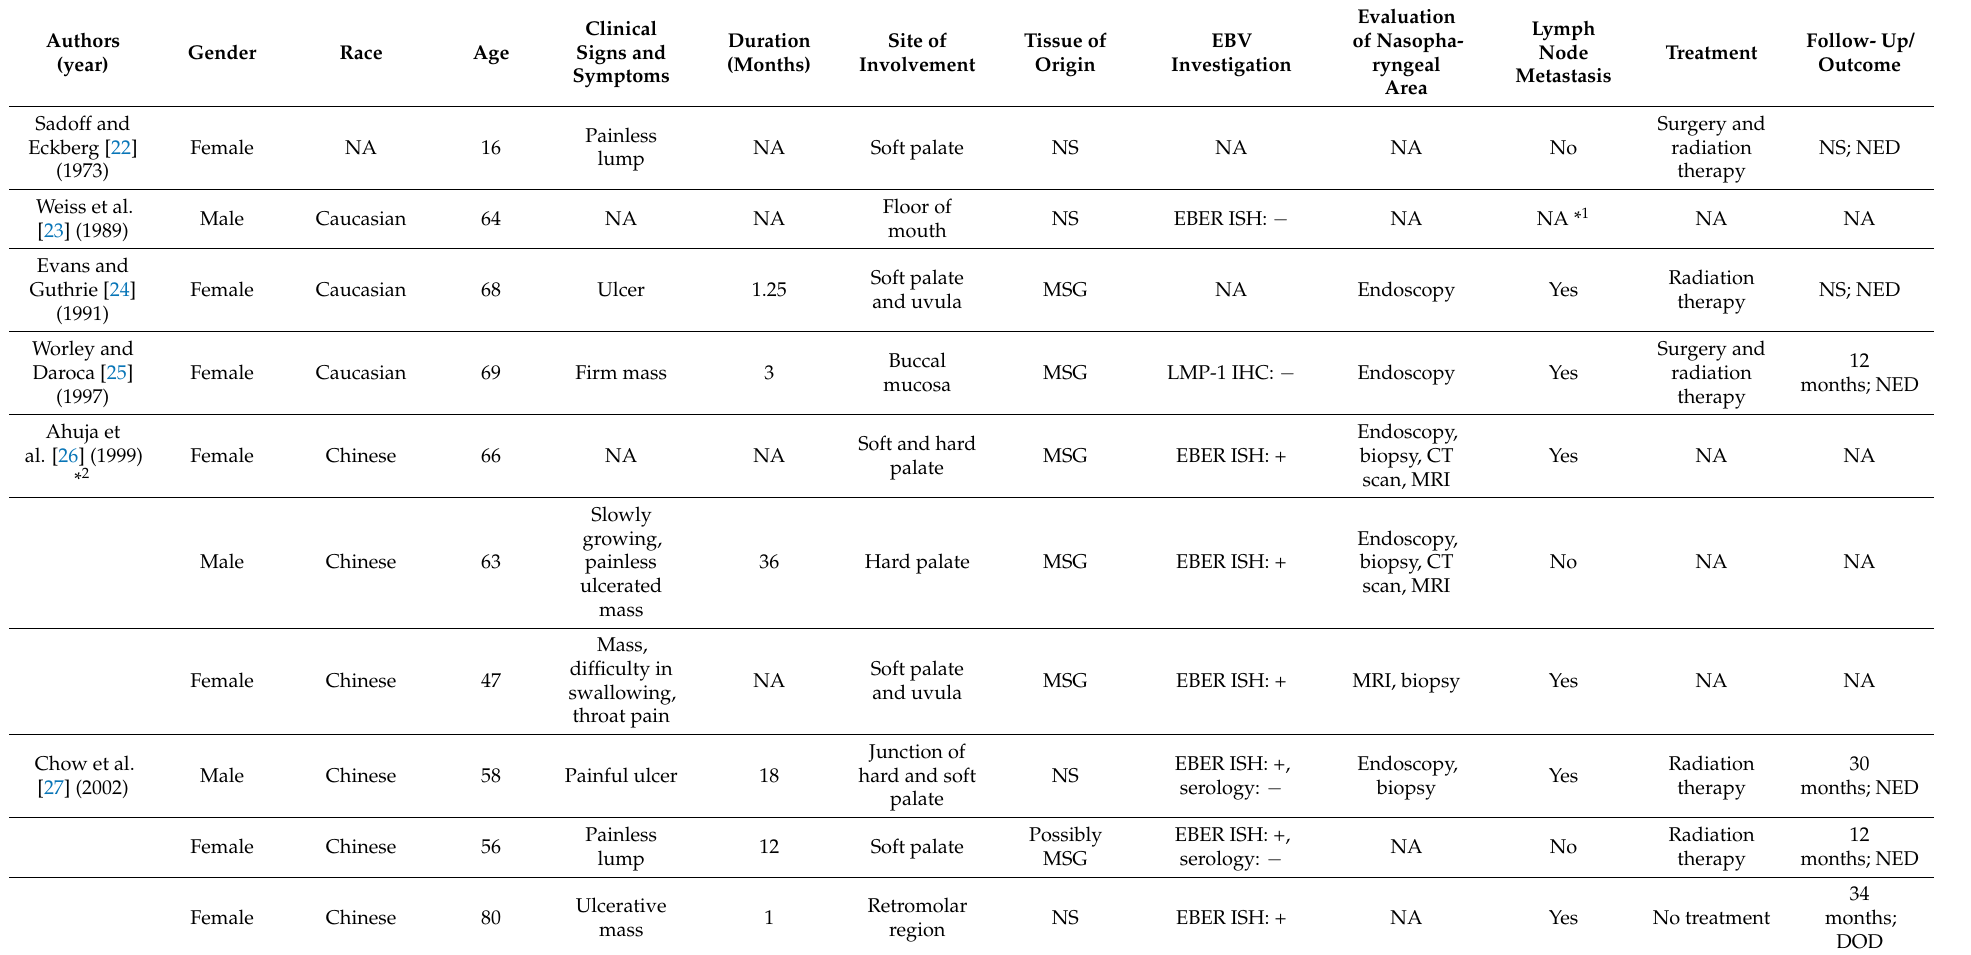
Table 1. Summary of published LEC cases of the oral cavity proper in English-language